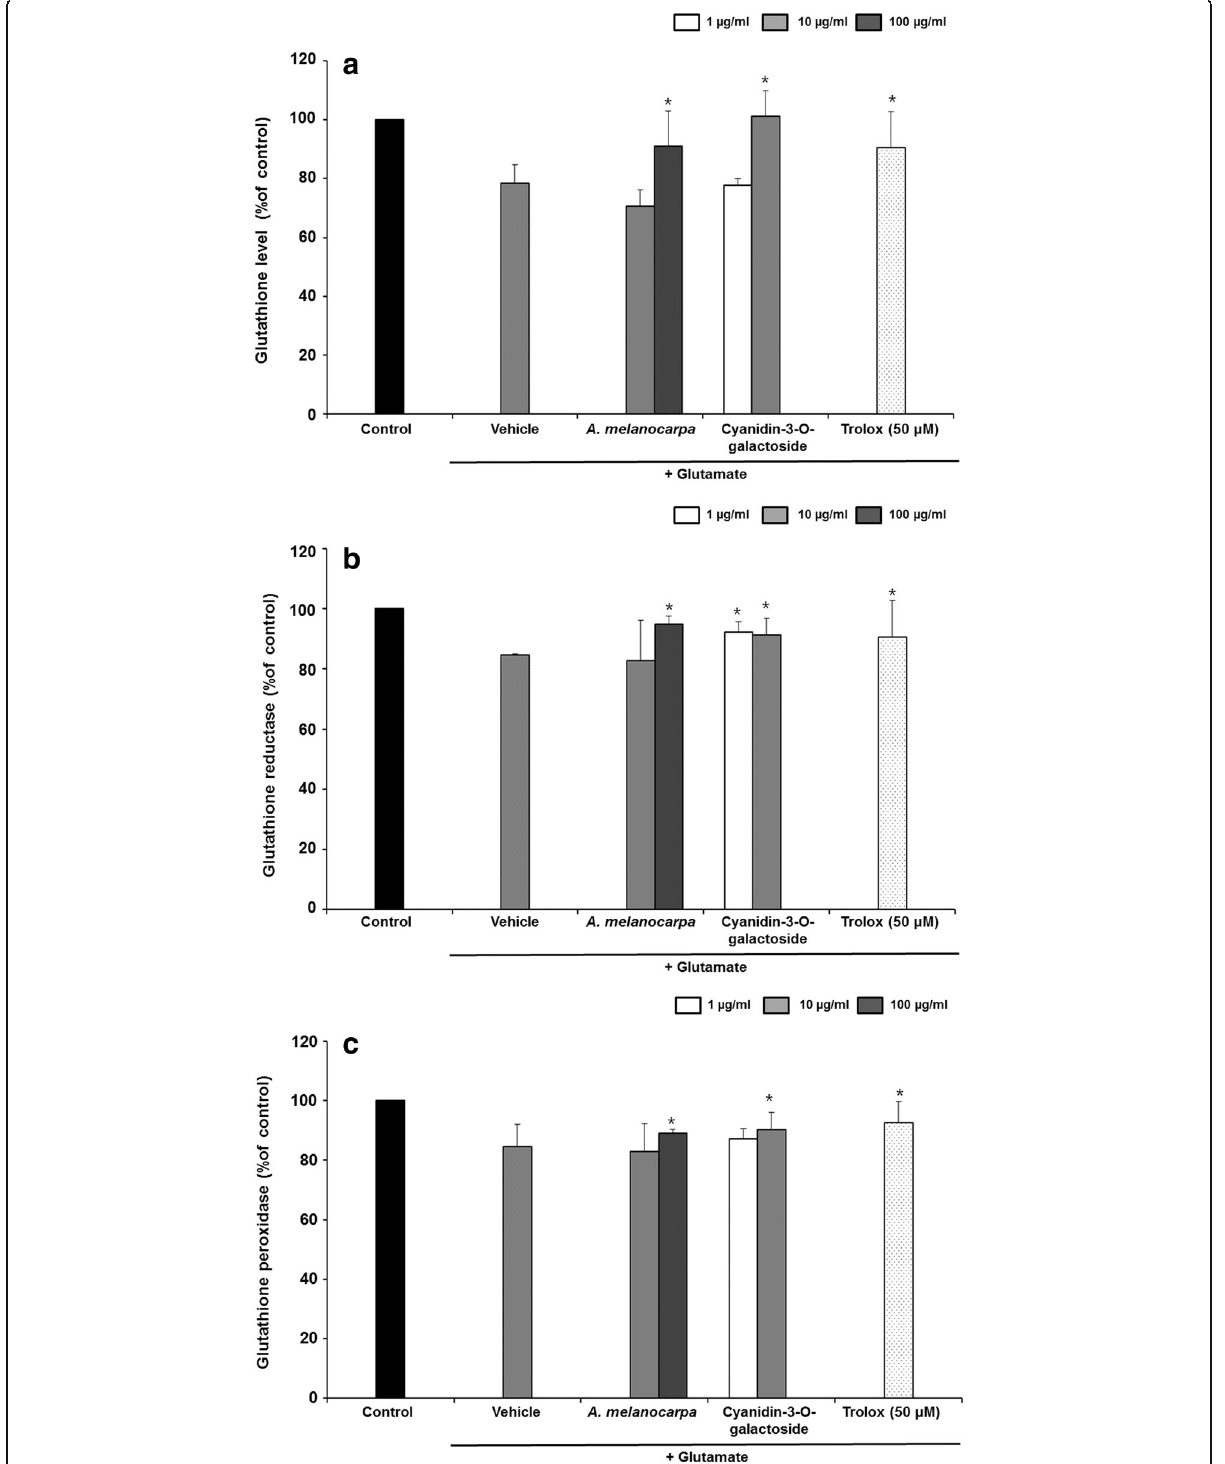
Fig. 5 Glutathione (GSH) a , glutathione reductase (GR) b and glutathione peroxidase (GPx) c levels in HT22 cells. Data are means ± S.D. * p < 0.05 versus the glutamate-treated